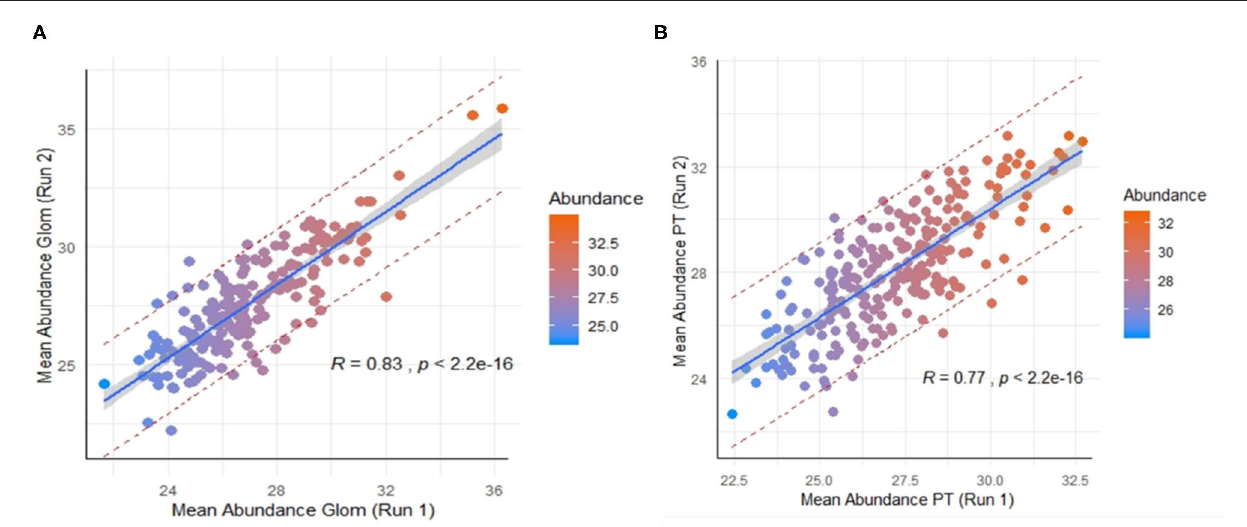
FIGURE 3 | (A) Correlation of a set of 210 proteins significantly enriched in glomerulus between two different batches of independent kidney samples. Batch 1 (run 1) was from 2 kidneys and Batch 2 (run 2) was from 4 kidneys. Color scale was selected for visual depiction of abundance. A strong positive correlation of 0.83 between the mean abundances of the same set proteins from two different batches The red dashed lines give a measure of the spread by depicting the 95% prediction interval for mean abundance values of these proteins in future repeat experiments. (B) Correlation of 246 proteins significantly enriched in proximal tubules vs. glomerulus between the two batches. A positive correlation of 0.77 between the mean abundances of these same proteins between the two